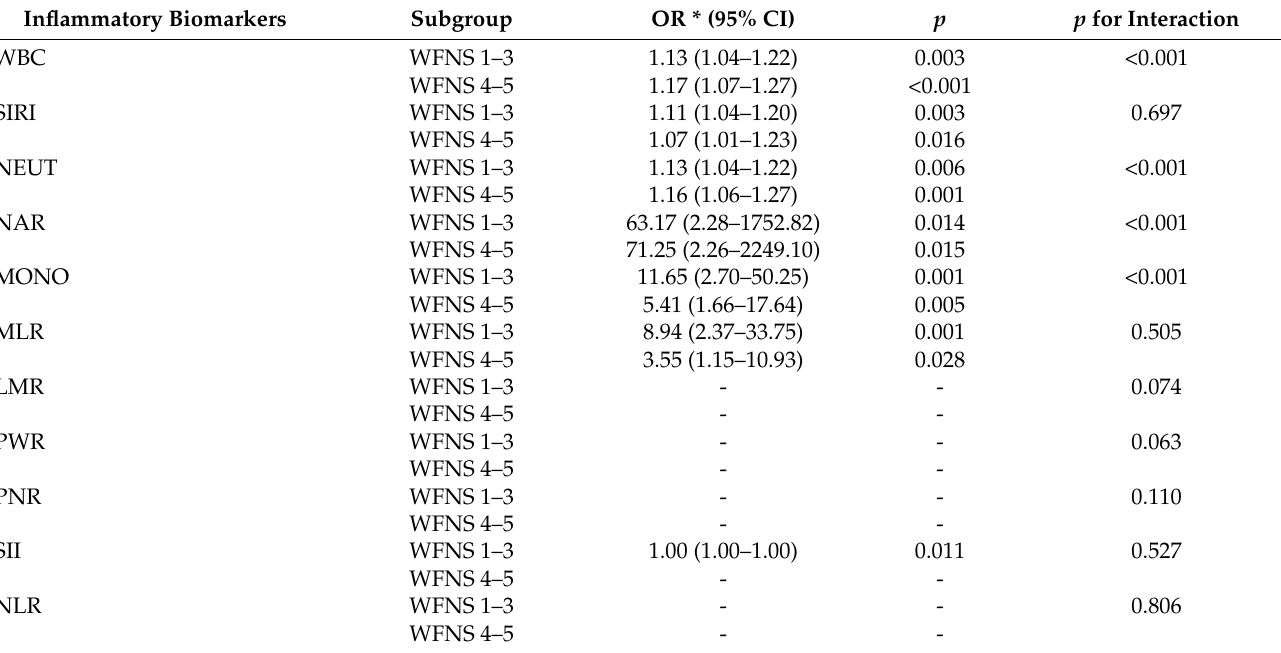
Table 3. WFNS grade subgroup analysis of 90-day unfavorable outcomes.